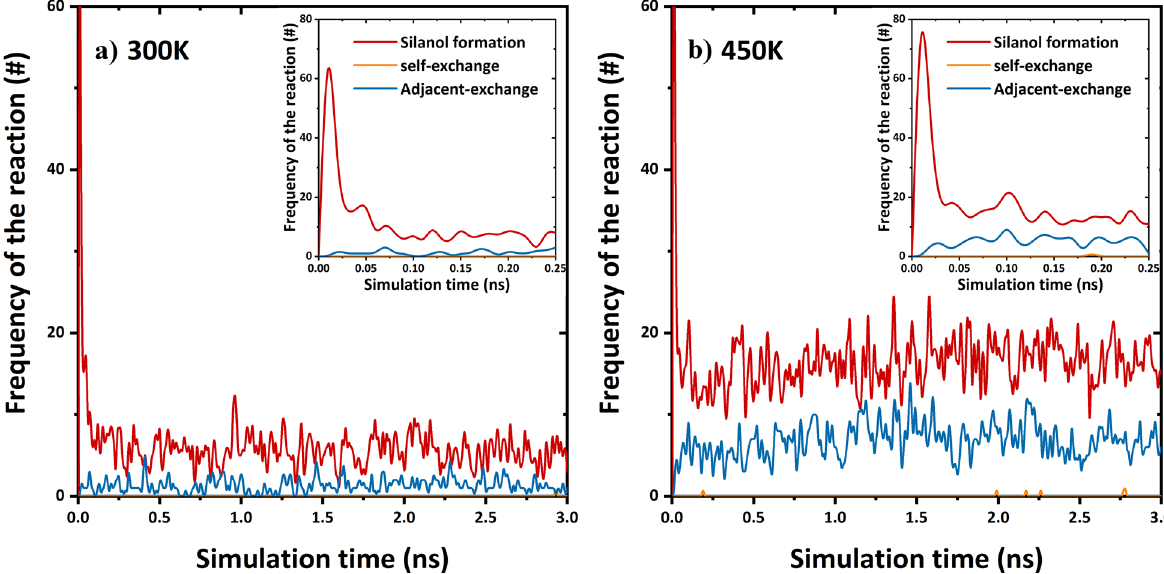
Fig. 11 Frequencies of the three ion-exchange mechanisms as a function of simulation time. a 300 K and b 450 K. Data were collected between two consecutive frames with a time interval of 10 ps. The zoomed-in fi gures show the initial reactions during the fi rst 0.25 ns duration.